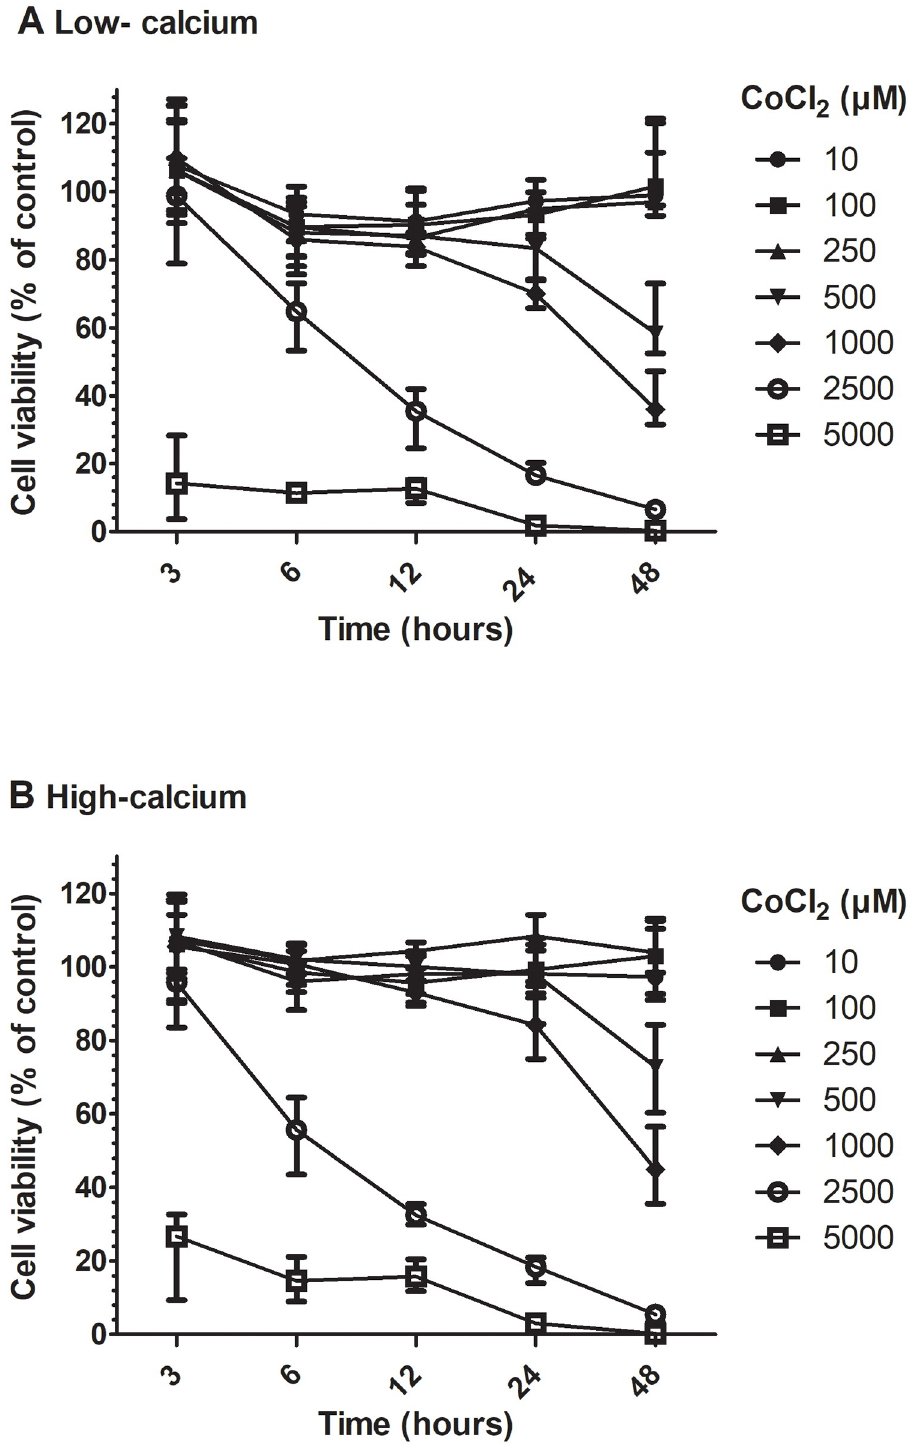
Fig 1. Cell viability for HaCaT cells exposed to cobalt chloride under low-calcium and high-calcium growth conditions. Cobalt chloride exposure concentrations are ranging from 10 μ M to 5 mM and exposure times are 3, 6, 12, 24 and 48 hours. The cell viability was measured with Cell Titer Blue viability assay and a dose- and time dependent decrease in viability was seen for low-calcium (A) and high calcium (B) growth conditions.